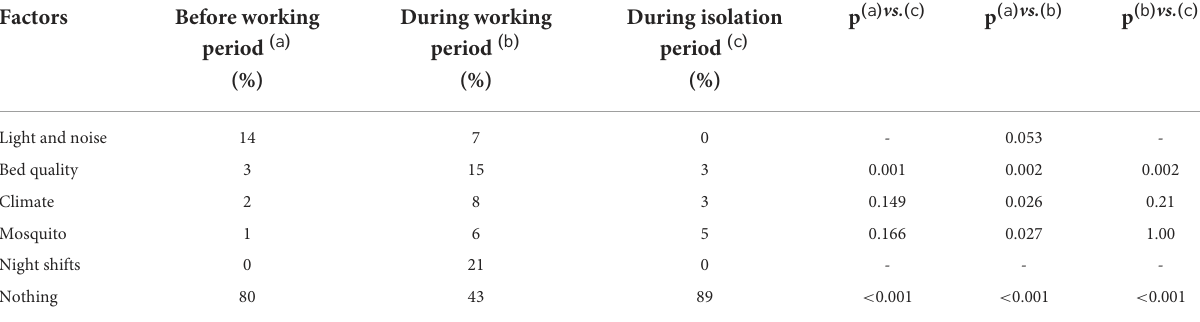
TABLE 2 Factors influencing sleep quality of study participants ( n =